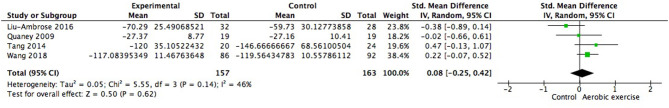
Meta-analysis of influence of aerobic training on response inhibition.